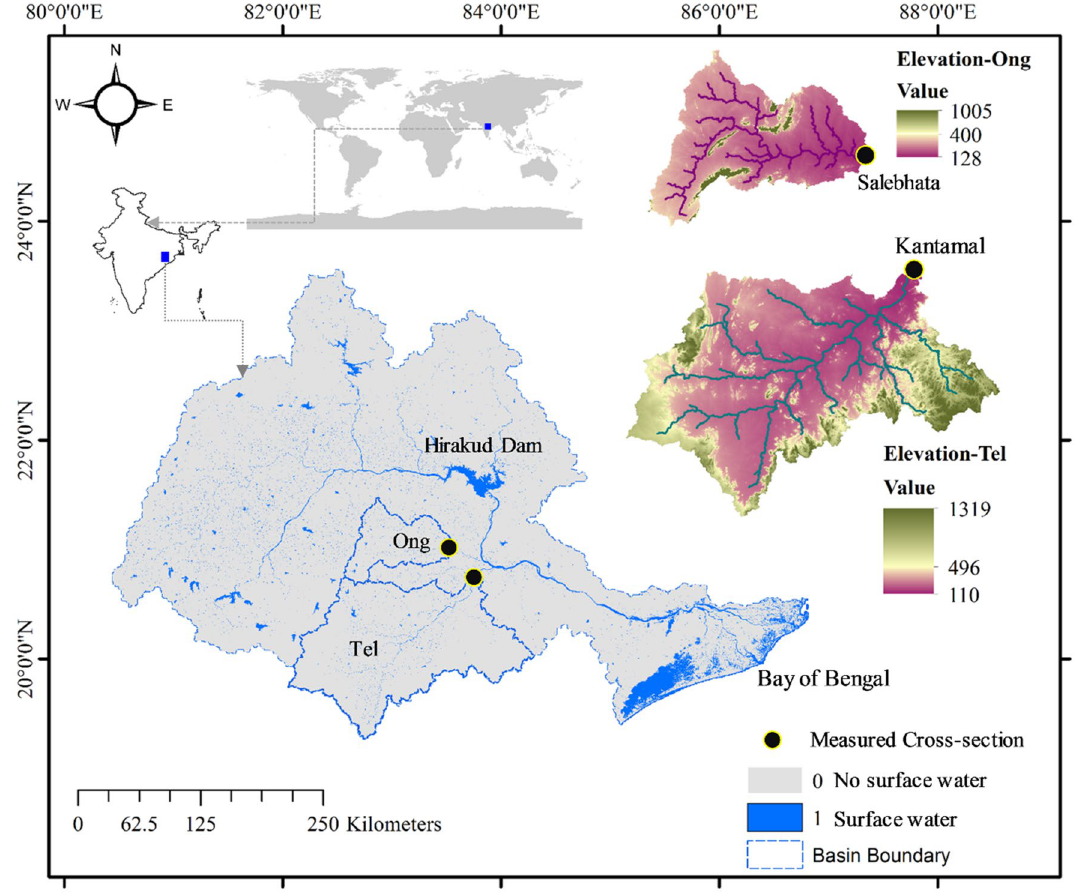
Figure 1. Study area showing the Ong and the Tel sub-basins of the Mahanadi River